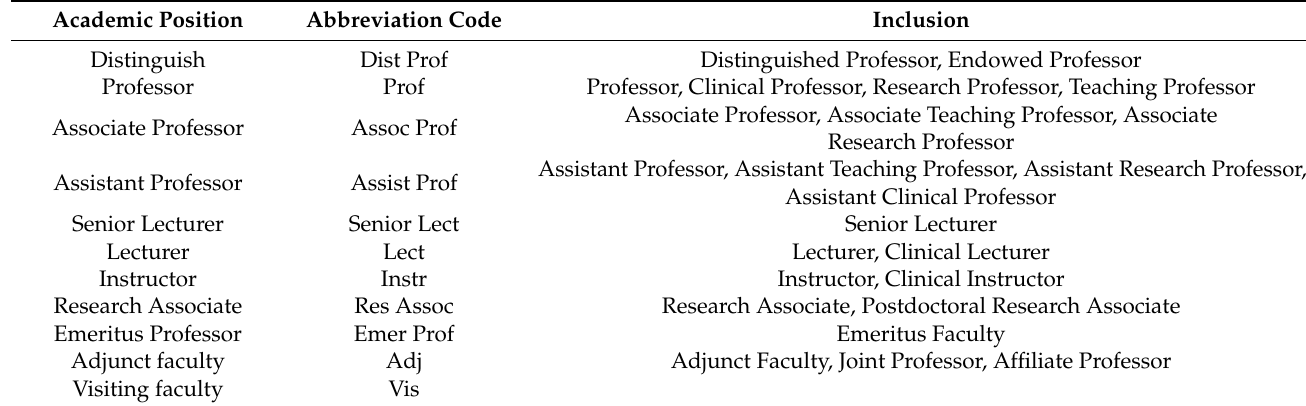
Table 3. Abbreviation codes for academic position in the